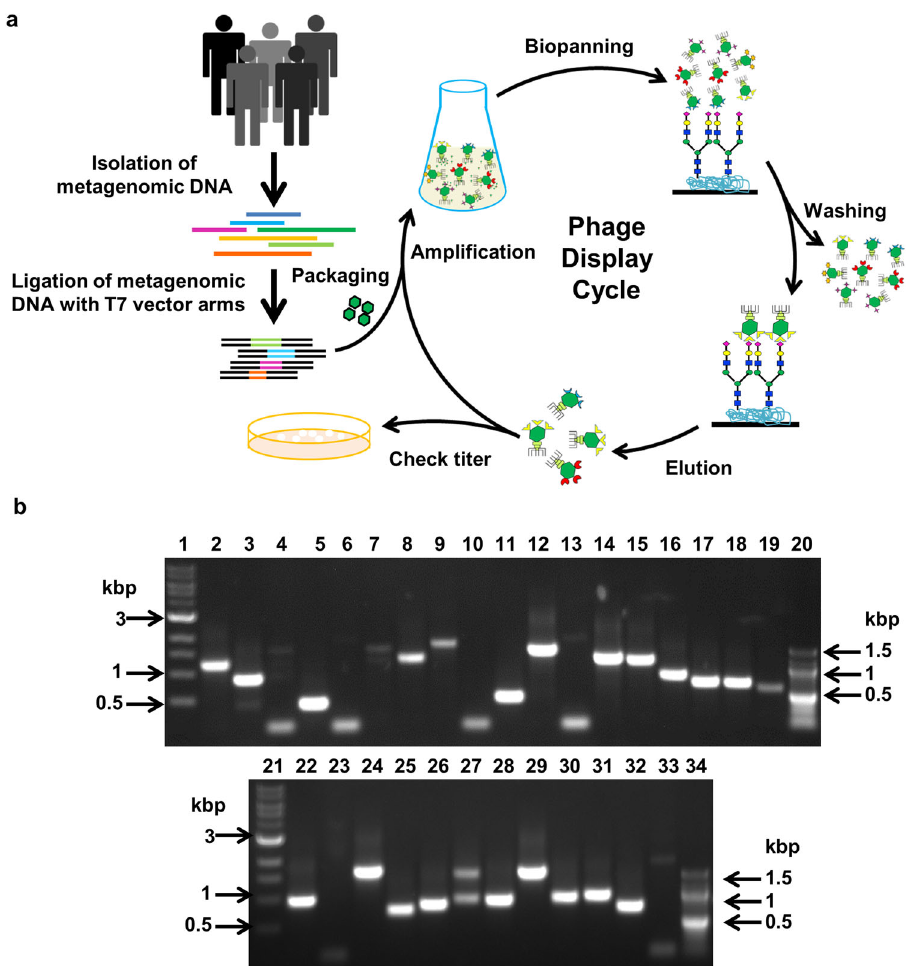
Fig. 1 Metagenomic phage display library. a Schematic representation of metagenomic phage display library preparation and biopanning to screen ligand binding recombinant phages. b Agarose gel electrophoresis of PCR amplicons indicating the presence or absence of any recombinant insert within randomly selected phages of the metagenomic phage display library. Results of a single screening experiment. Lanes 1 and 21: 1 kbp DNA marker (NEB). Lanes 20 and 34: 100 bp DNA marker (NEB). Lanes 2 – 19 and 22 – 33: PCR amplicons of the